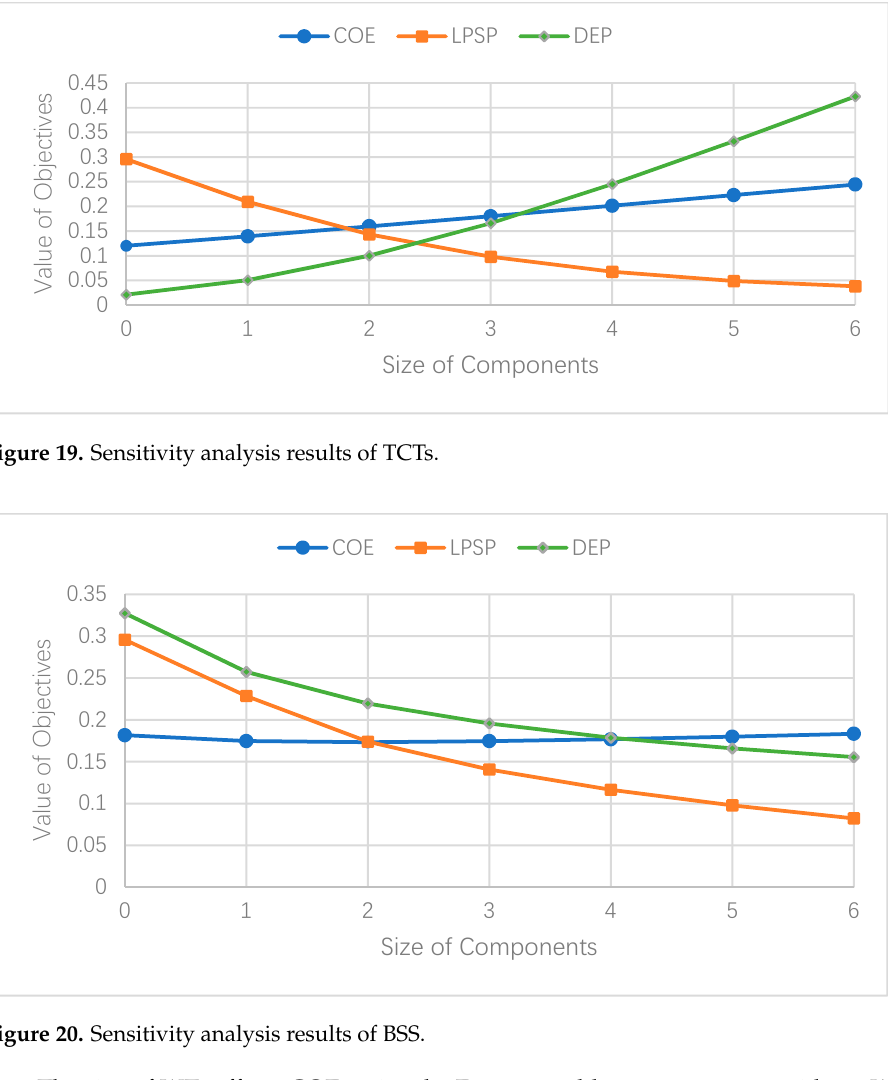
Figure 18. Sensitivity analysis results of WTs.